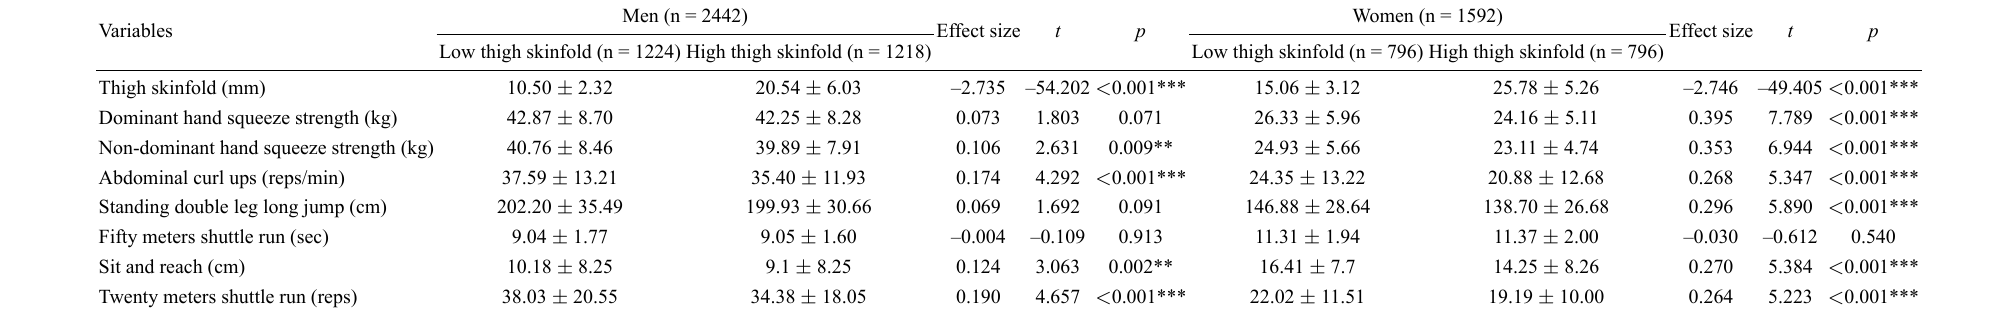
Table 2. Results from the independent t -test for sex differences in adults (aged 19–64